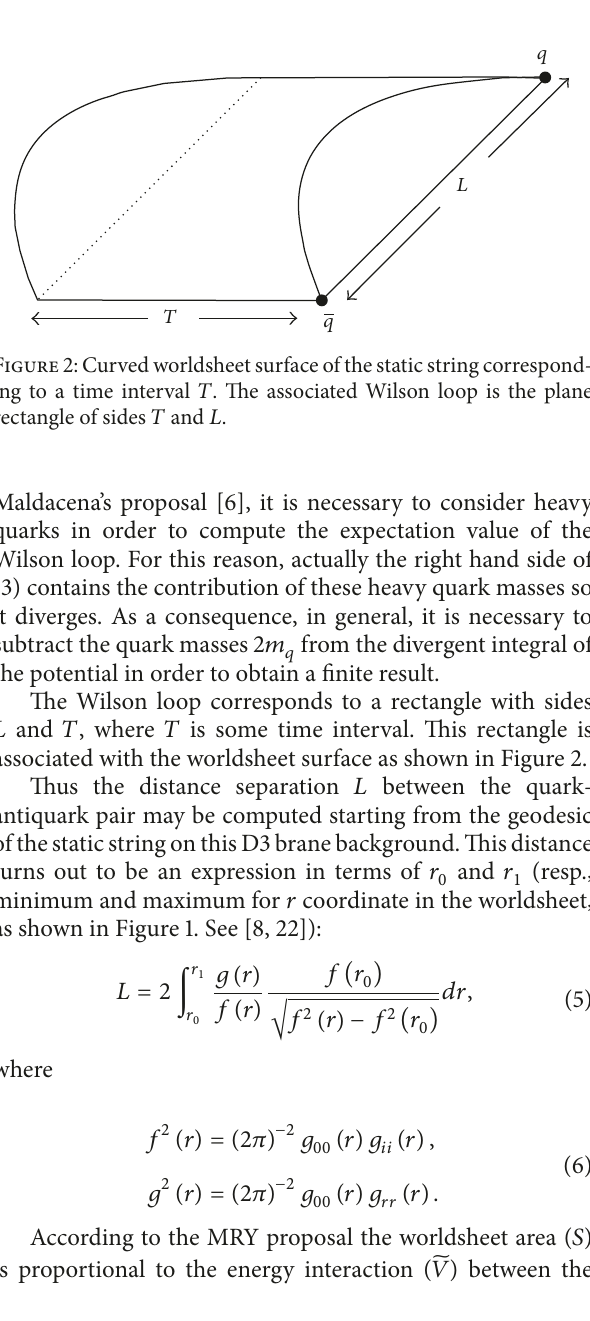
Figure 1: Position of quark 𝑞 and antiquark 𝑞 on the D3 brane (represented here by the 𝑥 -axis) together with the static string as the curve which connects 𝑞 and 𝑞 through 𝑟 0 .